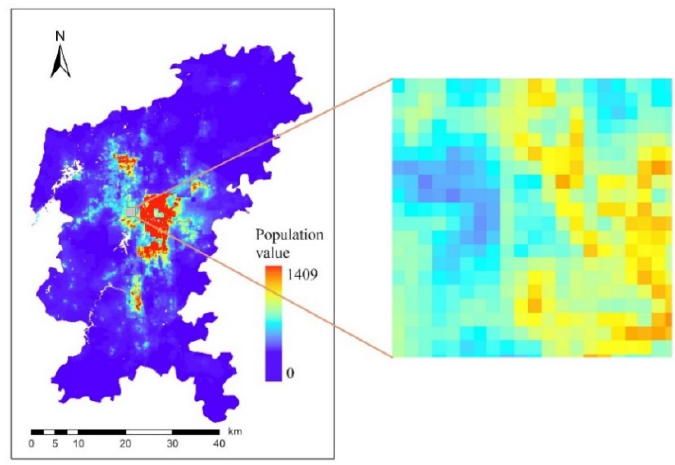
Figure 2. Original population data of the entire study area from WorldPop. The values are population per pixel 50 × 50 m 2 .